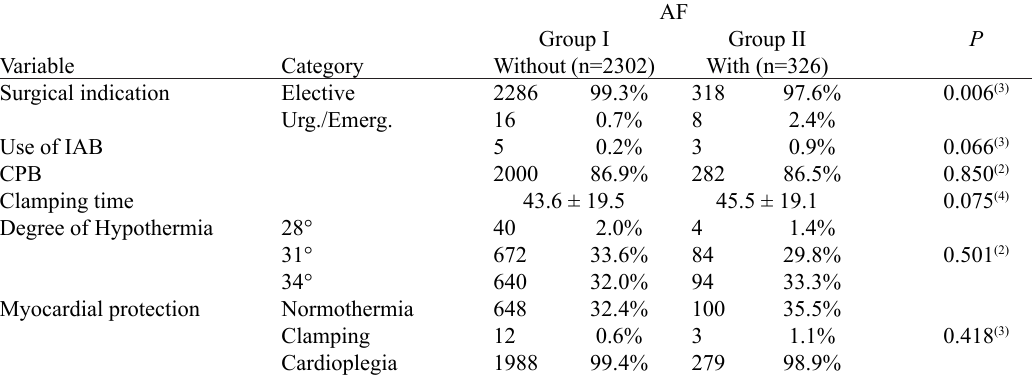
Table 2. Descriptive values of variables: surgical indication and intraoperative, according to the groups with and without POAF.